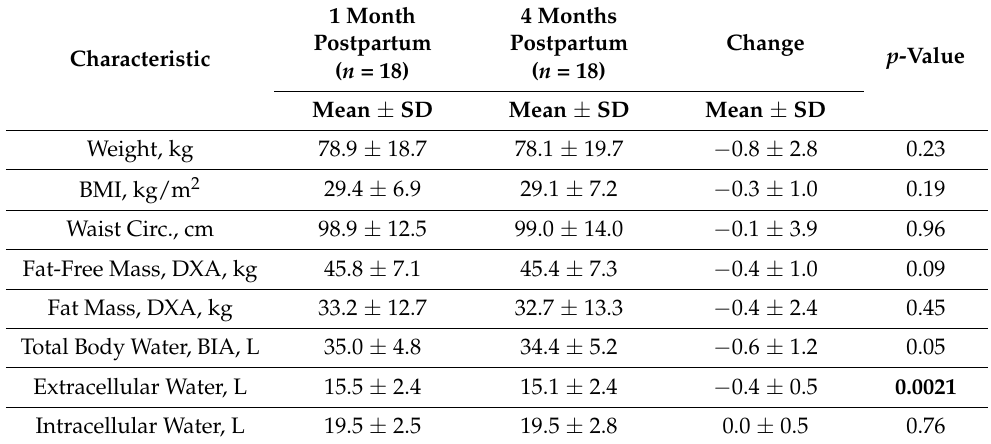
Table 2. Change in body composition between one and four months postpartum.